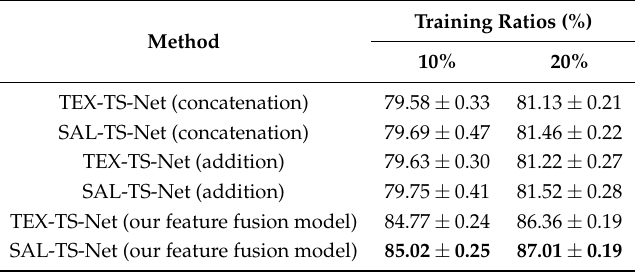
Table 4. Overall accuracies and standard deviations (%) of different feature fusion methods on the NWPU-RESISC45